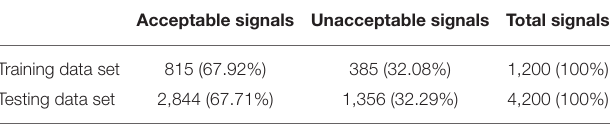
TABLE 2 | Results of the annotation and the total number of leads in the training and testing data sets.